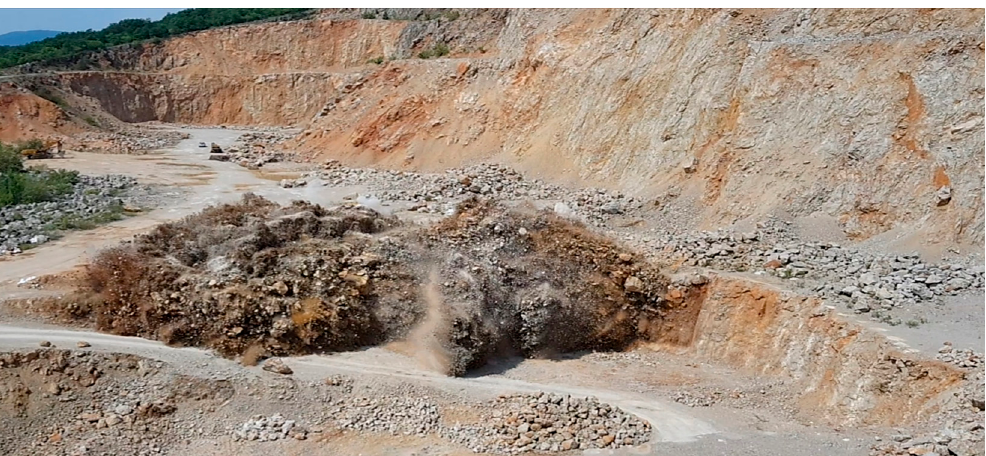
Figure 1. Bench blasting in quarry (source: author).